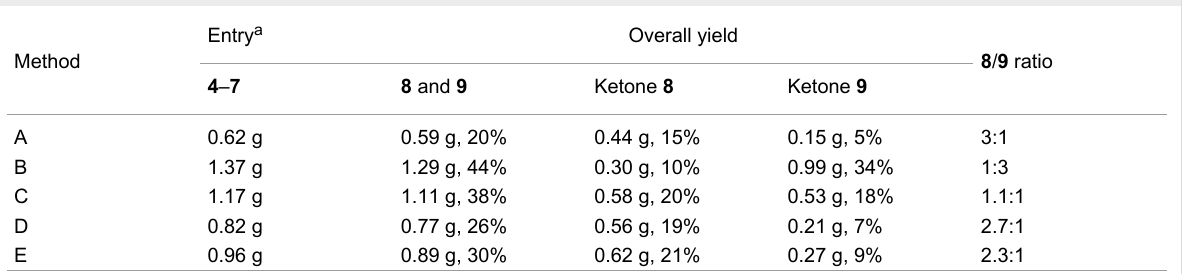
Table 2: Overall yields of 8 and 9 from oxidation of mixture of carbinols 4 – 7 .